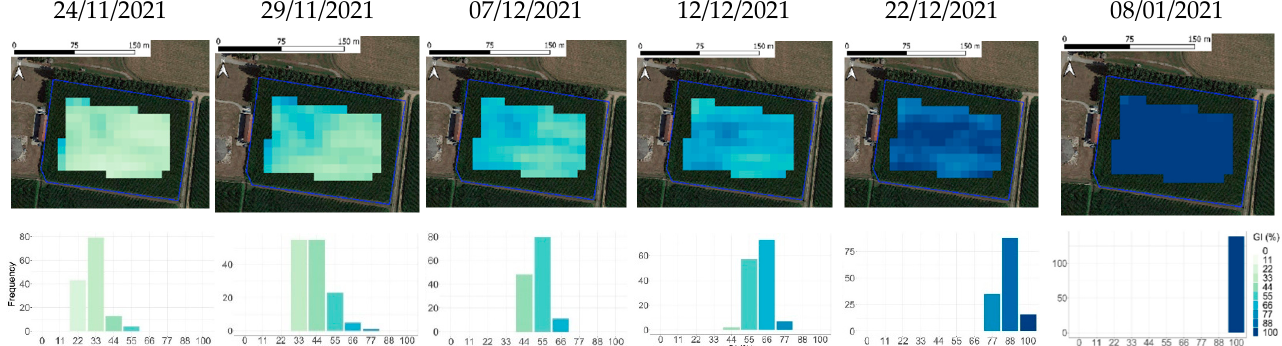
Figure 9. Maps of the frost damage index of a white mustard cover crop (GI, ranging from 0% = no damage, to 100% = complete crop destruction) estimated from MMSR for each satellite image available for the field in Alfianello during the monitoring campaign.